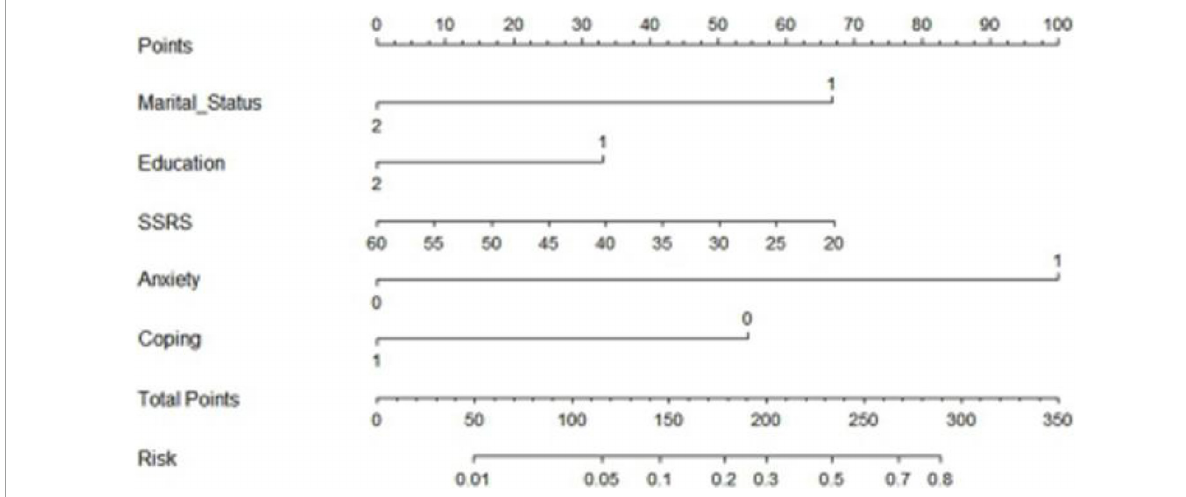
FIGURE1 Construction of the depression nomogram.